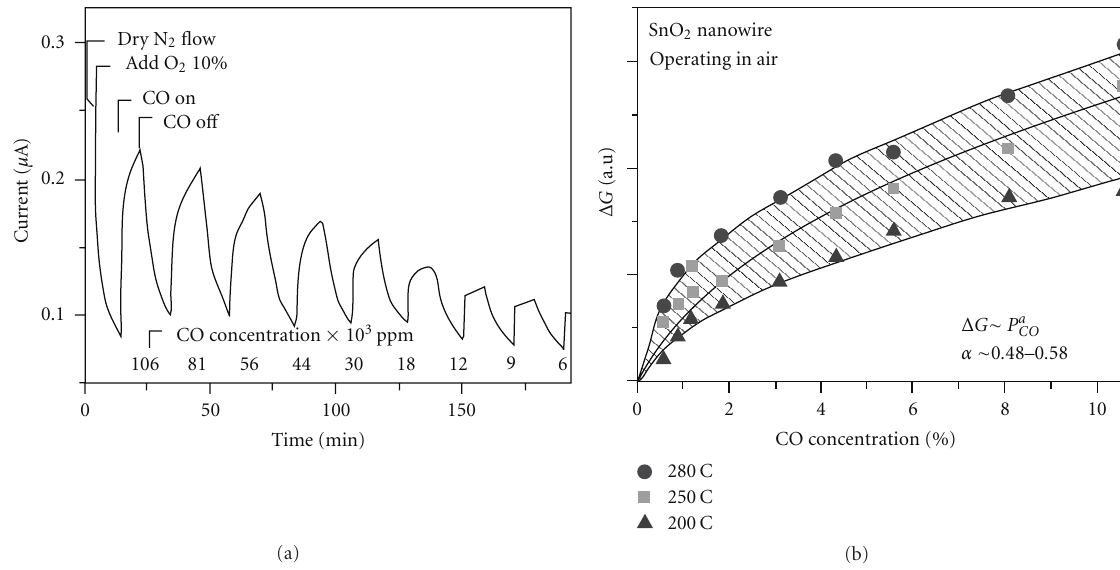
Figure 5: (a) Response of the SnO 2 nanowires towards CO pulses. (b) Change in conductance of individual SnO 2 nanowires as a function of CO concentration at three